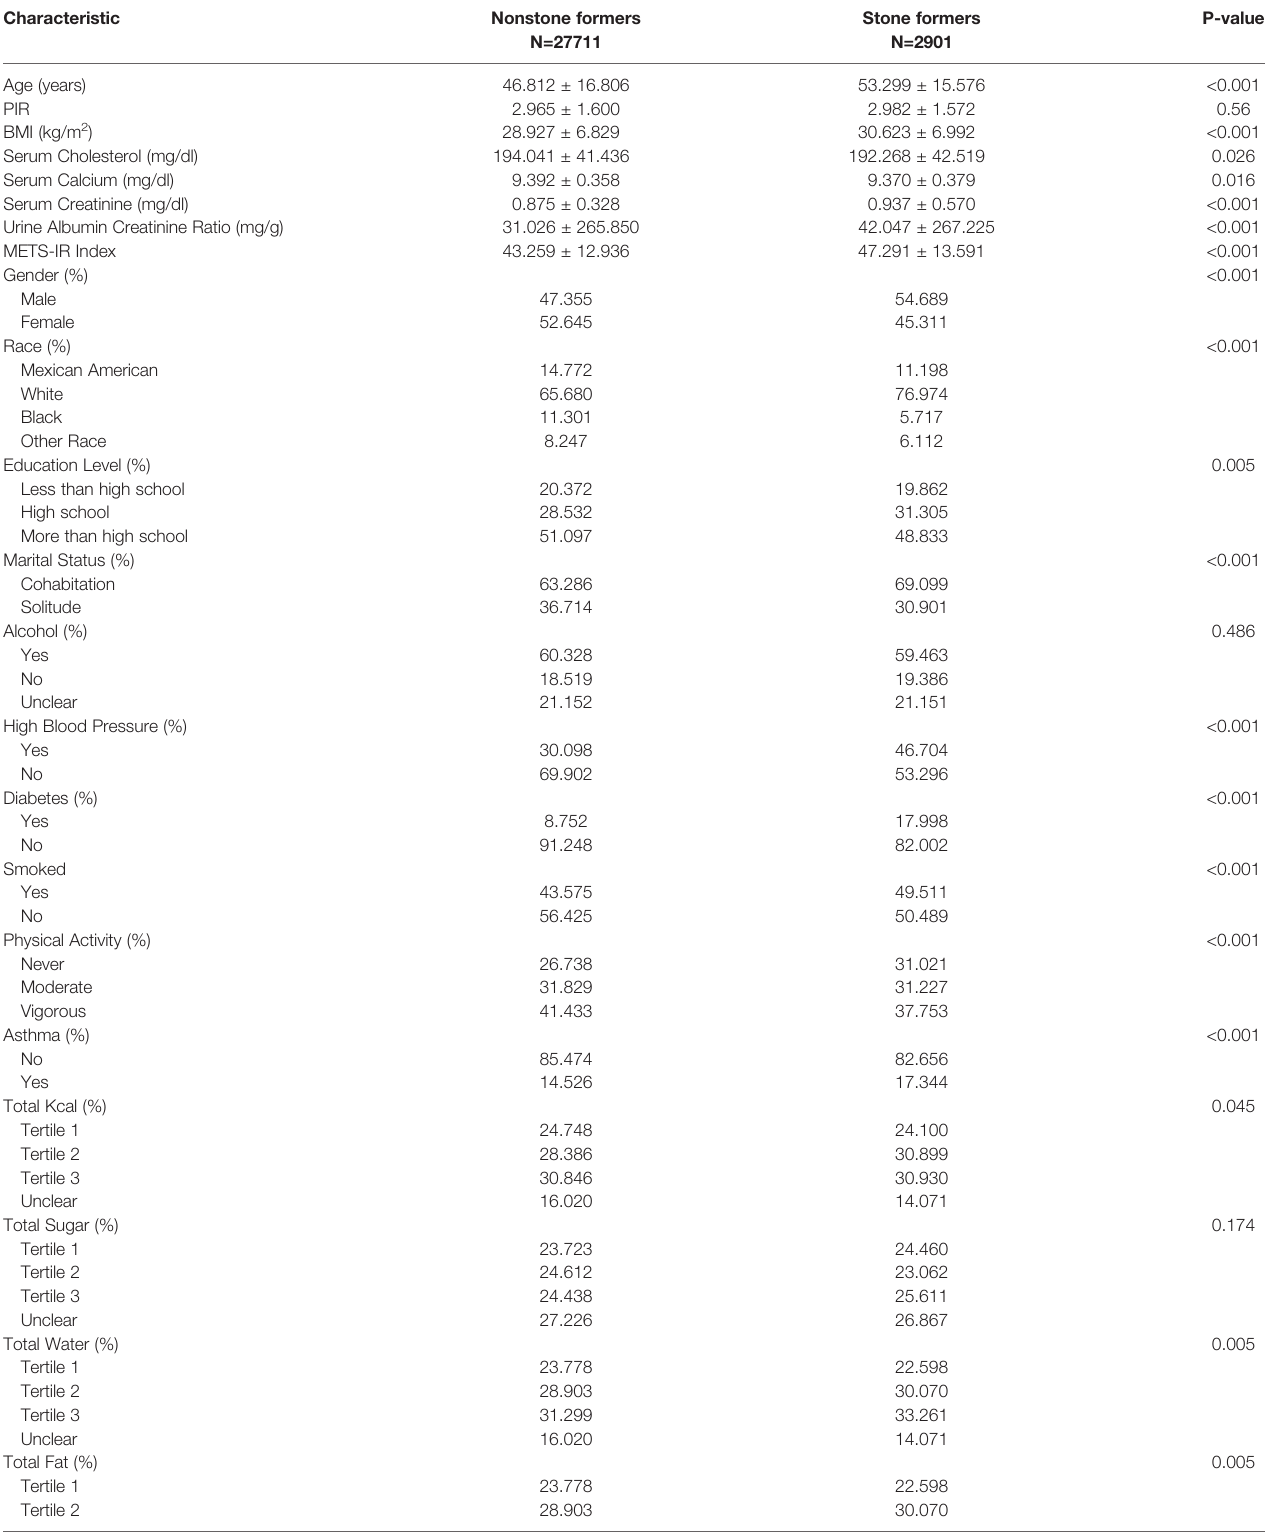
TABLE 1 | Baseline characteristics of